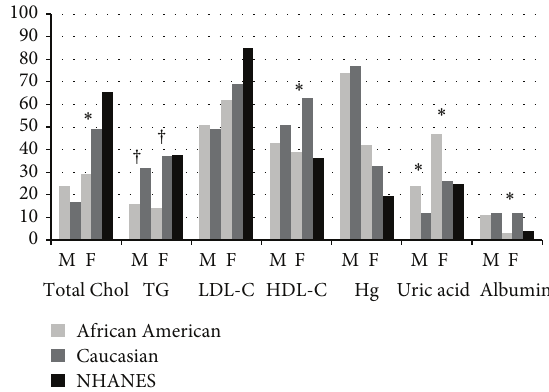
Figure 1: Bar graphs comparing the prevalence of serum concen- trations outside of recommended ranges in male (M) and female (F) African American and Caucasian stroke survivors ( ∗ 𝑃 < 0.05 , † 𝑃 < 0.01 significantly different by race within a gender) compared to NHANES. Total Chol = total cholesterol, TG = triglycerides, and Hg =